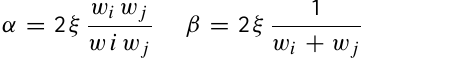
Figure 9. Damping Ratio and Shear Strain relationships for all formations.